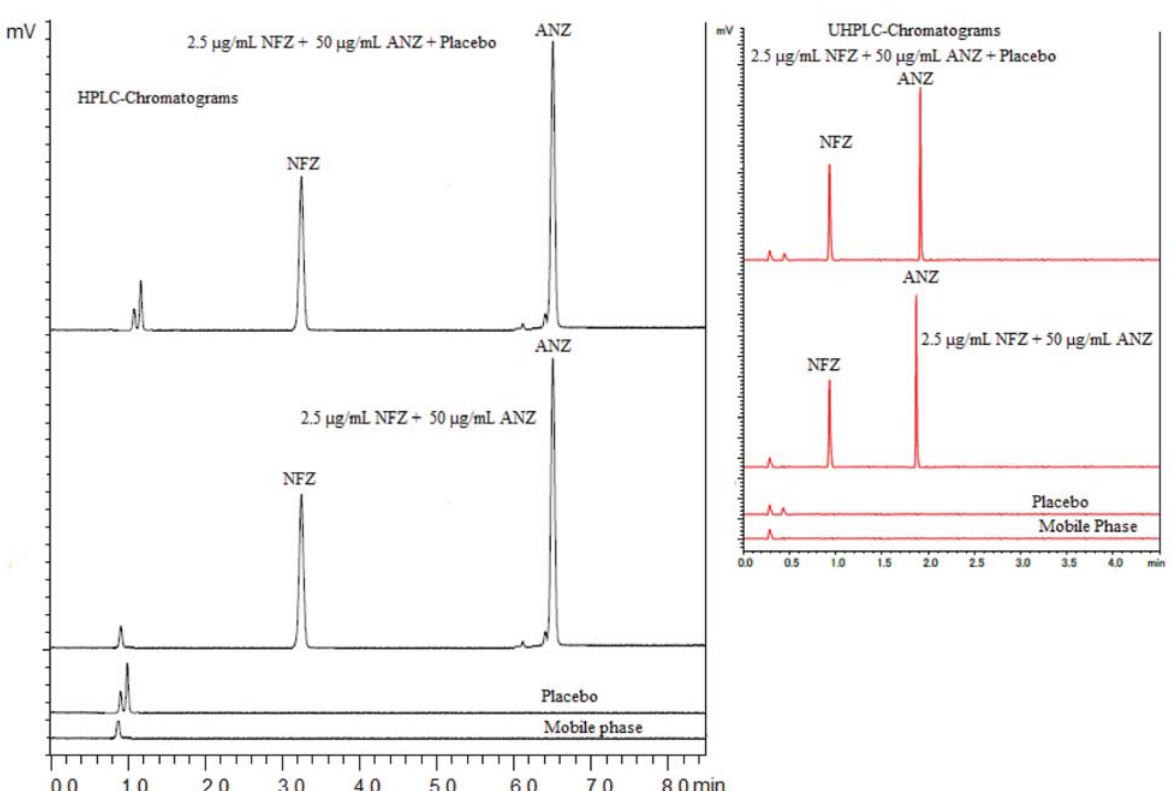
Figure 2. Typical HPLC and UHPLC Chromatograms of mobile phase, placebo, ANZ and